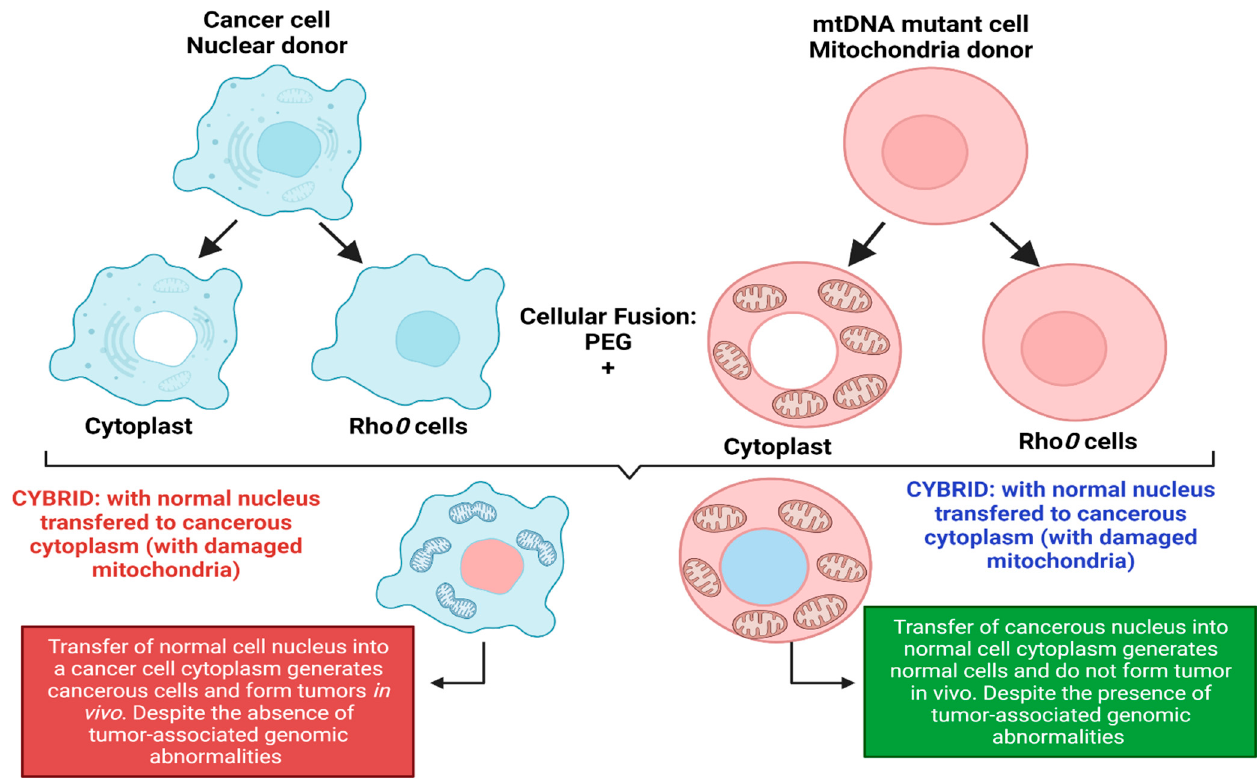
Figure 1. Nuclear–cytoplasmic studies (modified from the nucleus and mitochondria in the origin of tumors as previously described by Seyfried, 2012d; Seyfried et al., 2014). These studies involved